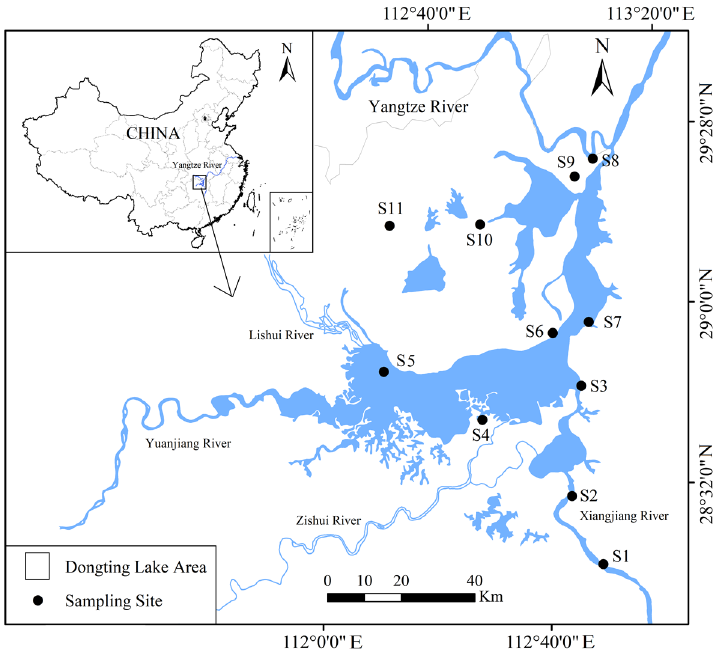
Figure 1. Location of the 11 in situ sampling sites within the Dongting Lake